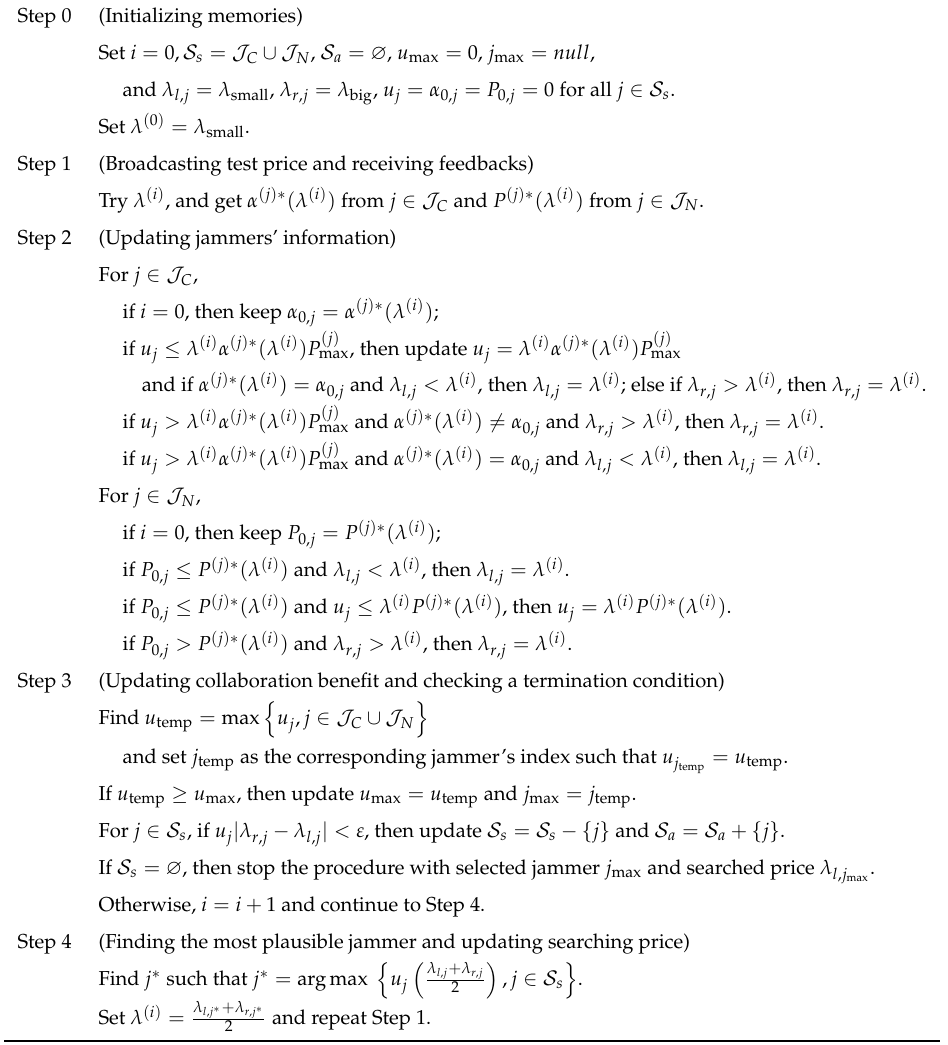
Table 2. Interactive collaboration search procedure